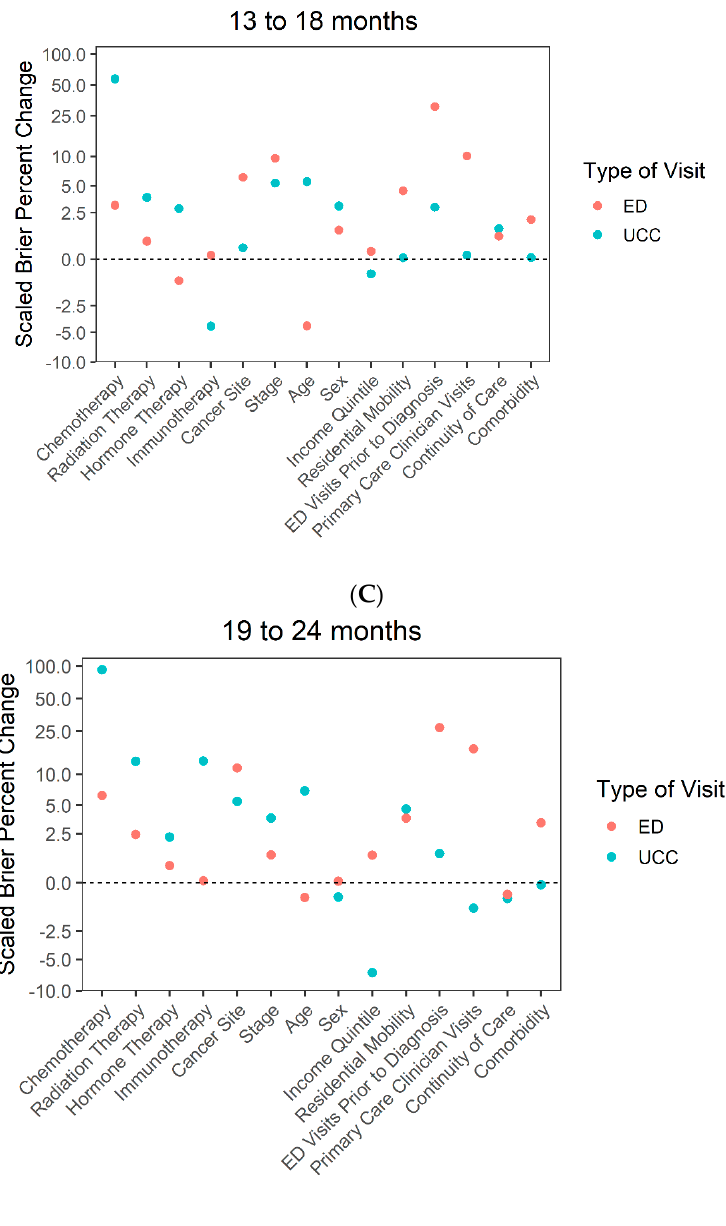
Figure 2. Impact of each predictor on UCC and ED visits by follow-up period, ( A ) 1 to 6 months, ( B ) 7 to 12 months, ( C ) 13 to 18 months and ( D ) 19 to 24 Table 2. Multivariable logistic regression model describing factors associated with UCC visits stratified by follow-up time period.